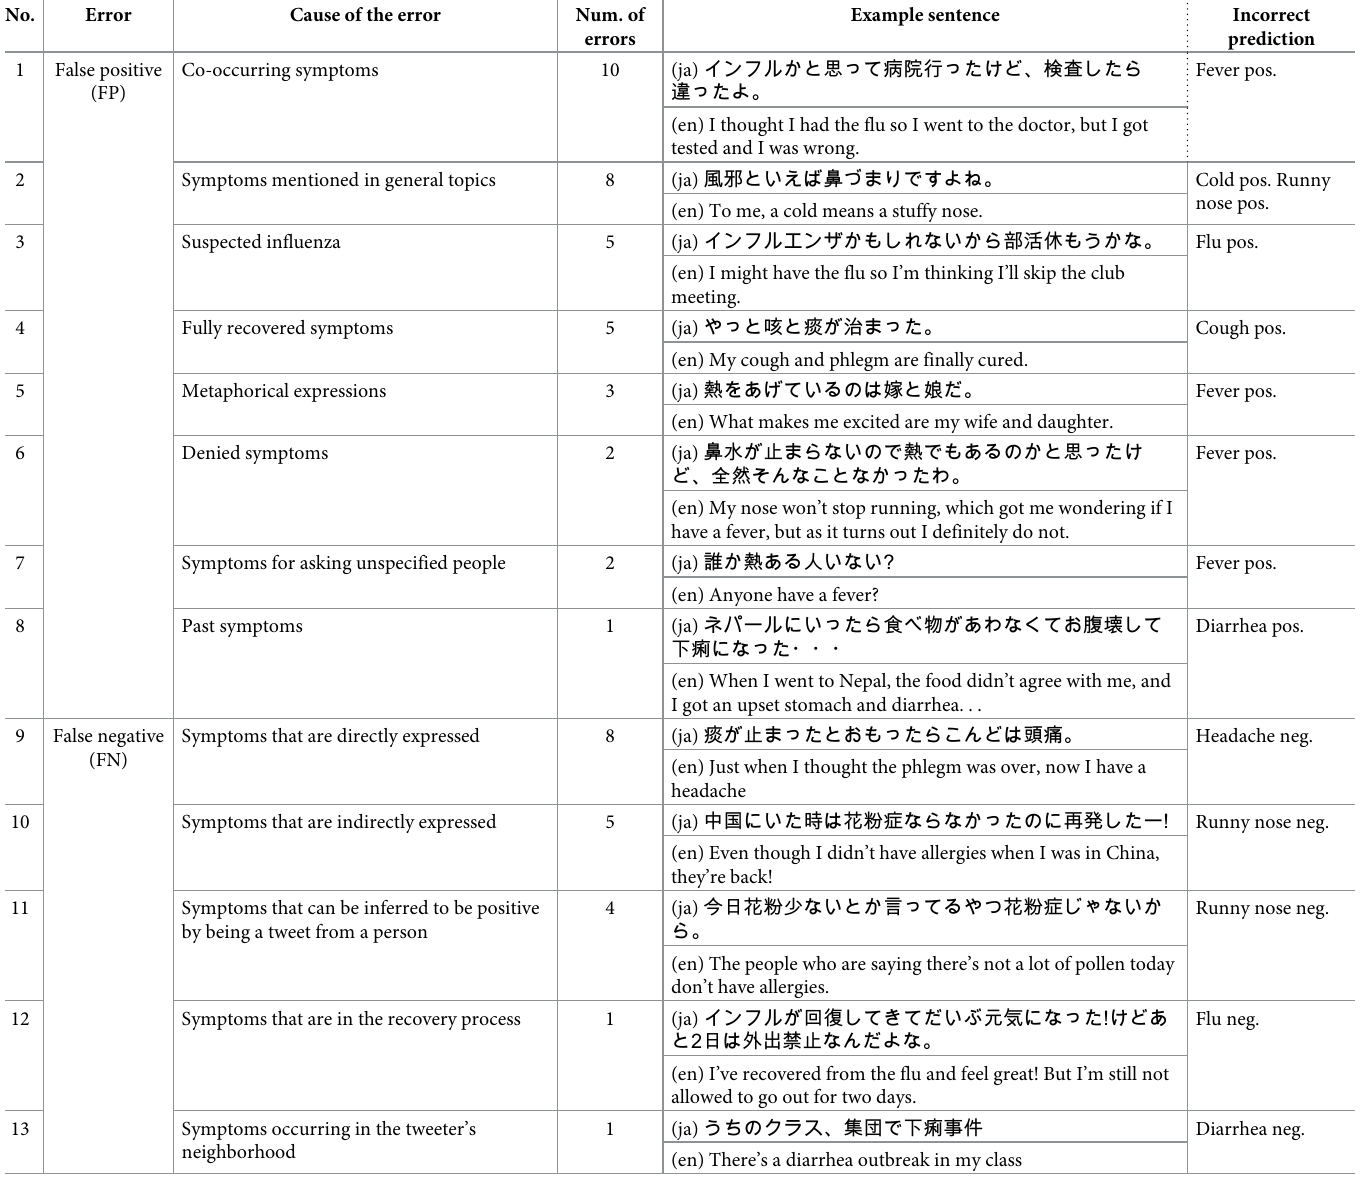
Table 6. Interpretations obtained from the results of the error analysis.